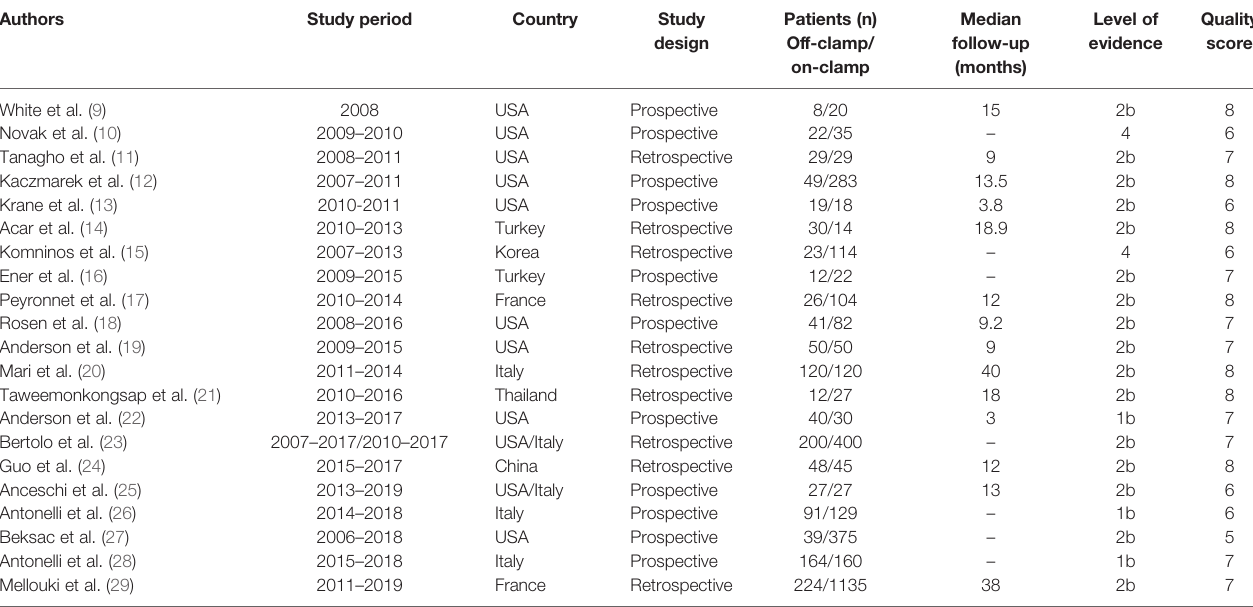
TABLE 1 | Baseline characteristics of include studies and methodological assessment.